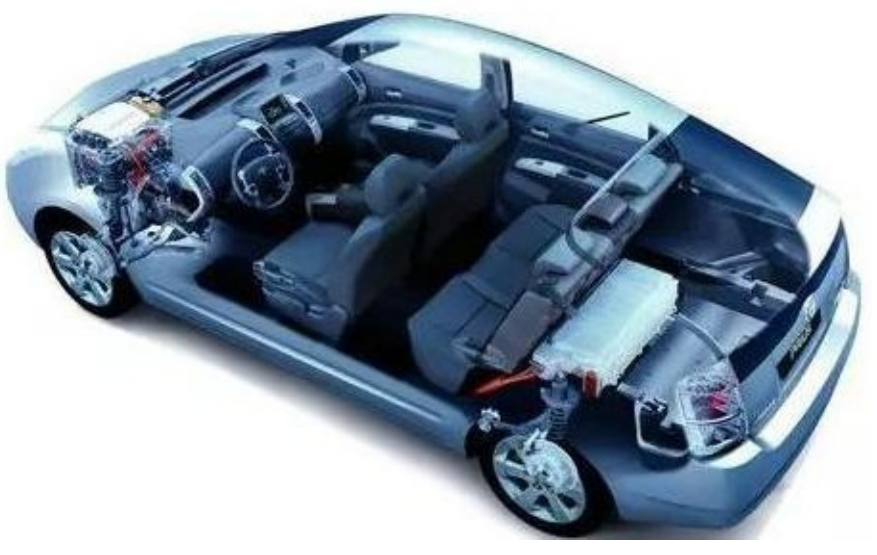
Figure 1. Interior space of the car.